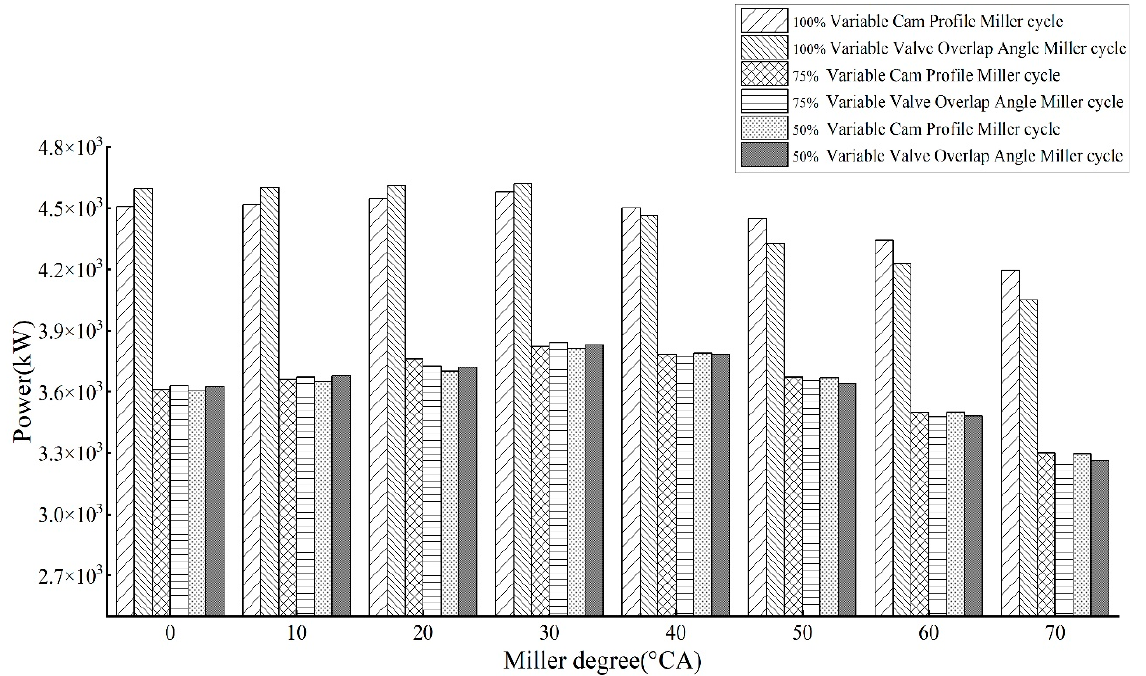
Figure 5. Power analysis under three working conditions.